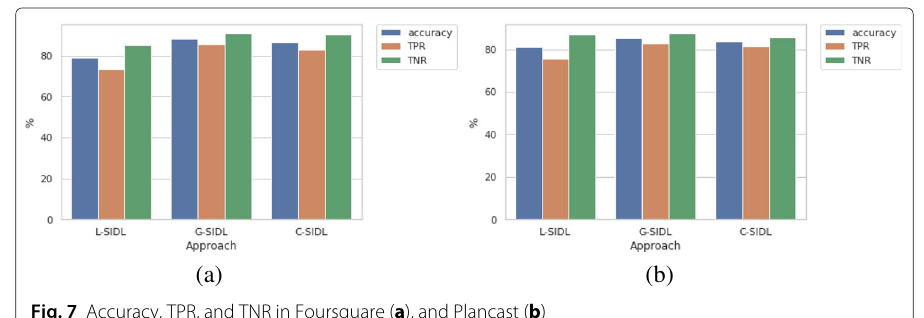
Fig. 7 Accuracy, TPR, and TNR in Foursquare ( a ), and Plancast ( b